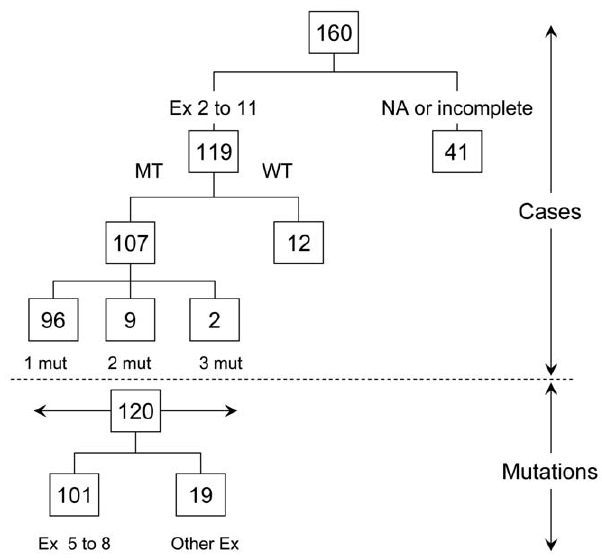
Figure 1. Flow chart summarizing the analyses carried out on ESCC cases used from the Golestan Case-Control Study and the number of mutations detected. Of a total of 160 cases, 119 were fully sequenced for exons (Ex) 2–11 whereas 41 were either not available (NA) or incompletely sequenced. Numbers of samples with mutations (MT) or with wild-type TP53 (WT) are indicated. Among MT cases, the number of cases with 1, 2 or 3 mutation(s) (mut) is given. Below the dotted line, the total number of mutations (120) is broken down into mutations in exons (Ex) 5 to 8 or in other exons.